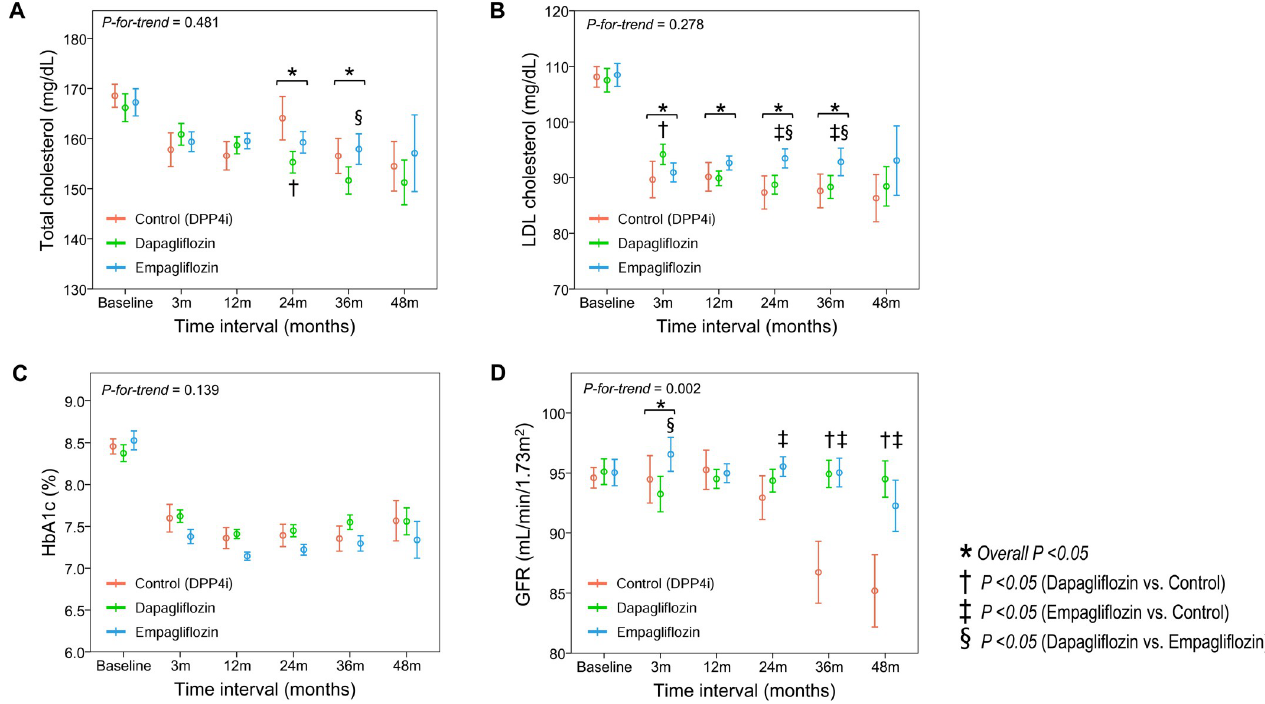
Fig 4. Changes in laboratory findings. Serial changes in (A) total cholesterol, (B) LDL cholesterol, (C) HbA1c, and (D) GFR are plotted according to group. GFR, glomerular filtration rate; HbA1c, glycosylated hemoglobin; LDL, low-density lipoprotein; SGLT2i, sodium-glucose co-transporter 2